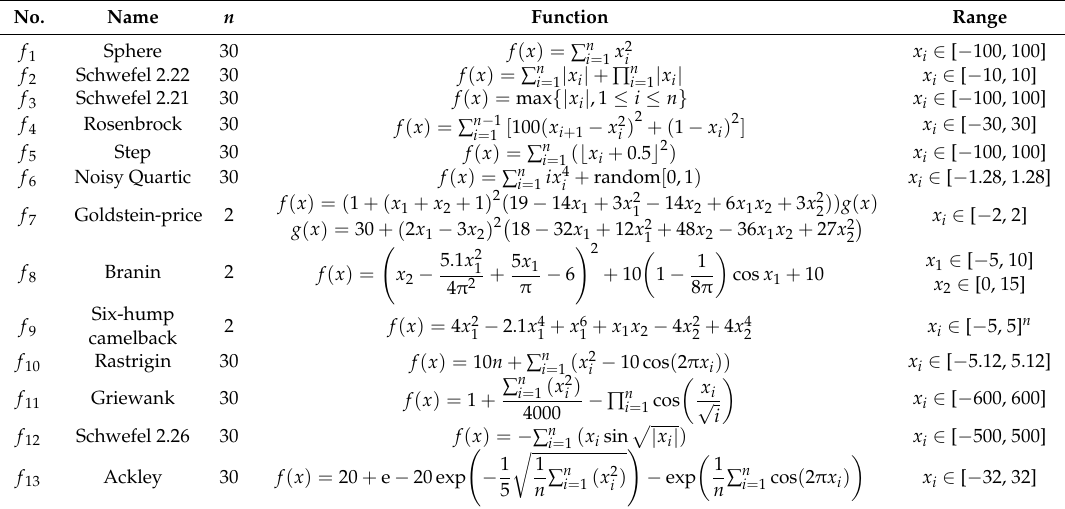
Table 2. Test functions used for the